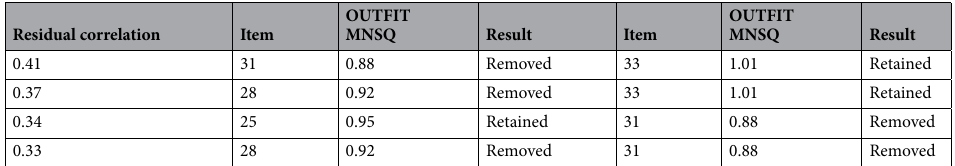
OUTFIT Residual correlation Item MNSQ Table 2. Local dependency analysis by means of Yen’s Q3 statistic. Pair of items with a residual correlation > 0.2 above the average correlation (0.12) indicate dependency. In this case, residual correlation greater than 0.32 between them were shown. Items with an outfit MNSQ closed to 1 were retained. (MNSQ: mean square).